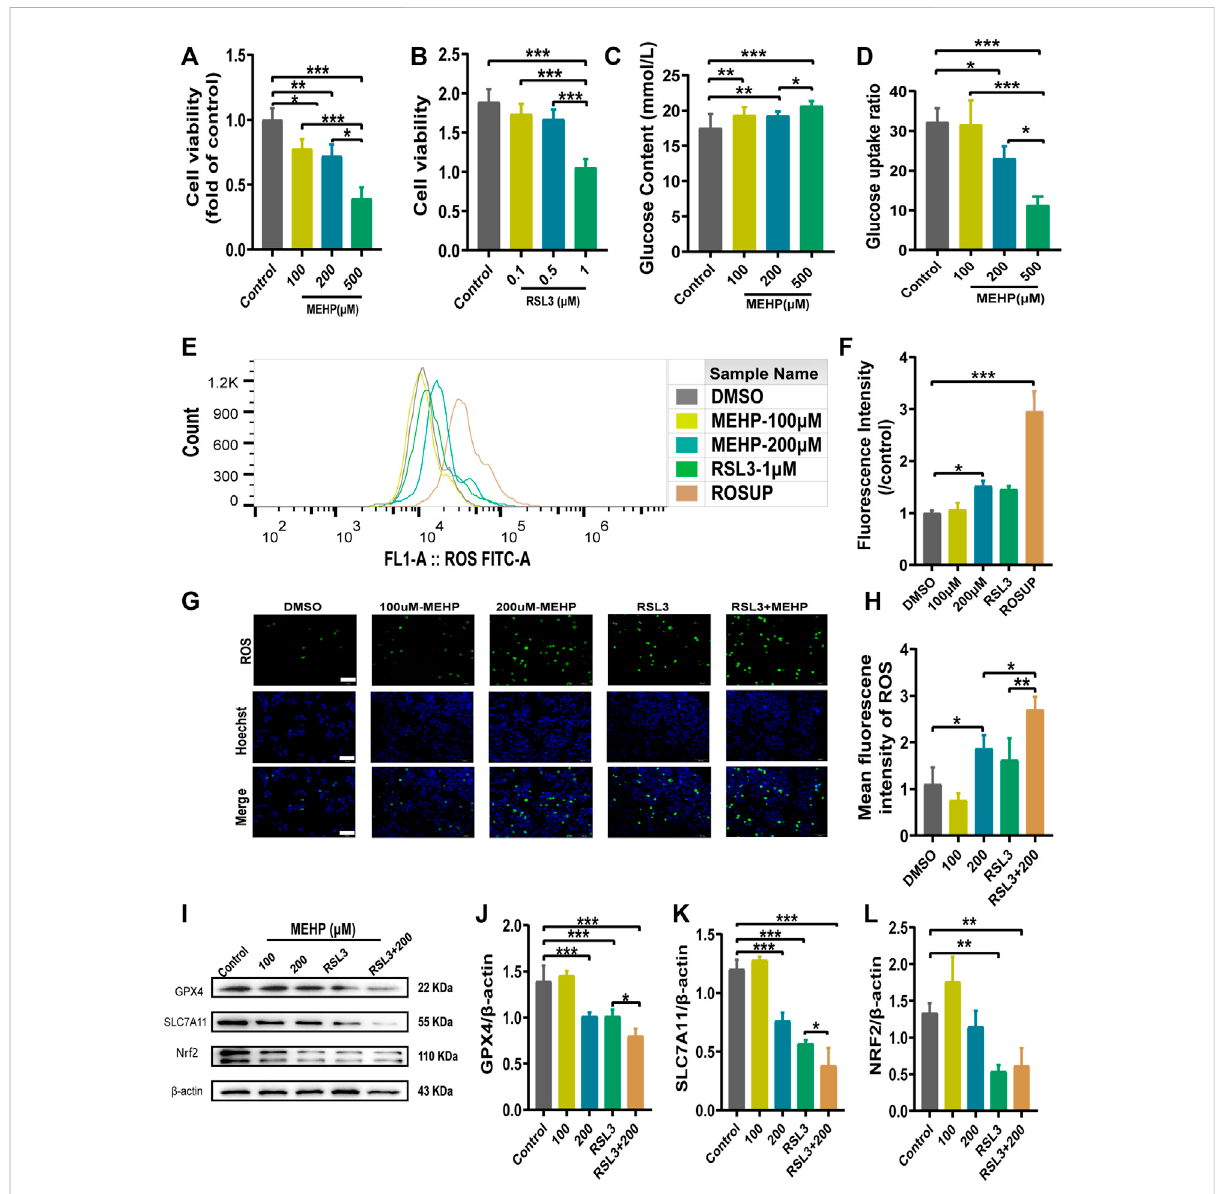
FIGURE 6 MEHP induced ferroptosis in HepG2 cells. (A,B) Cell viability was detected by CCK8 assays. (C,D) The glucose level and glucose uptake ratio wereassessedbyassays. (E – H) The intracellularROS level wasanalyzed byaDCFH-DA probe on a fl uorescence microscope and fl owcytometry. (I) Protein levels of GPX4, SLC7A11, and Nrf2 in HepG2 cells; β -actin was used as the reference protein. (J – L) Quanti fi cation of the protein levels of GPX4, SLC7A11, and Nrf2 inHepG2 cells. Experimentswererepeatedatleastthree times.Data are presented as themean± SD.* p < 0.05, ** p < 0.01, *** p <